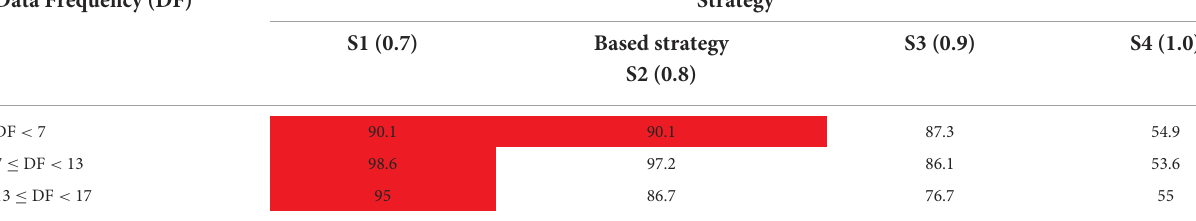
TABLE 8A Probabilities of the OPREM meeting the lower band width given the data frequency. Data Frequency (DF)